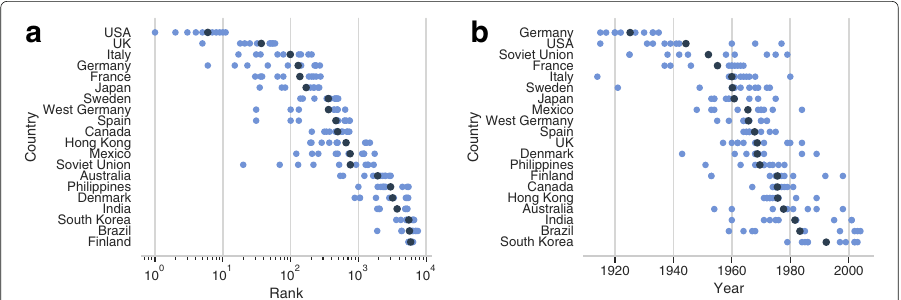
Fig. 4 Rank and year of release of top 10 movies in each country, in cyan: dark points represent average. a Rank, b Year of